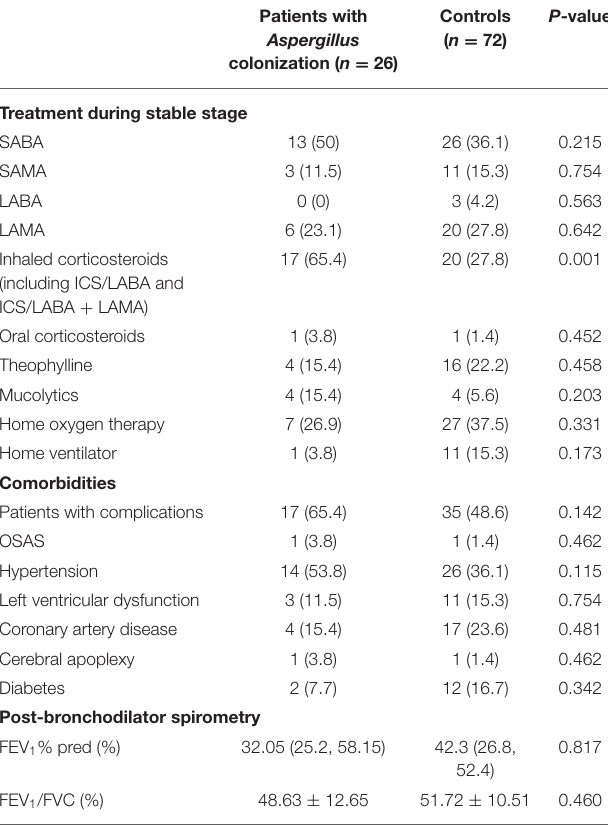
TABLE 2 | Treatment during the stable stage, comorbidities, and airflow limitation of hospitalized COPD patients with or without Aspergillus colonization. Patients with Aspergillus